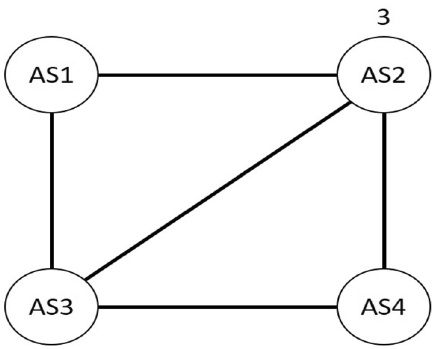
Figure 8. An example of four ASs with their adjacency